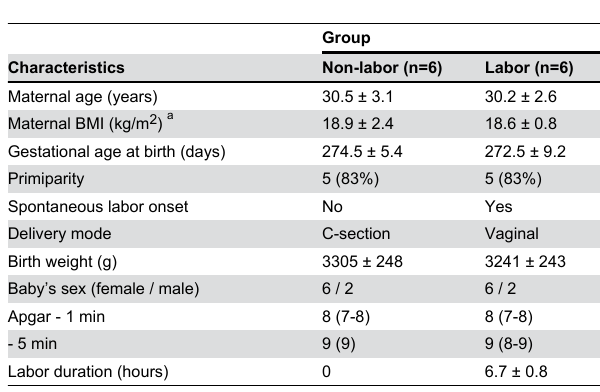
Table 1. Clinical characteristics of the pregnant mothers from which the placentas were